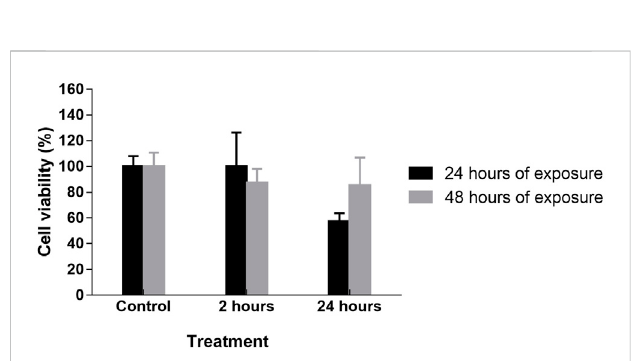
Analysis of Ag@ACF cytotoxicity expressed by cell viability percentage of Vero cells, DMEM treated for 2 and 24 h. Cytotoxicity assessed by MTT assay and cell viability evaluation veri fi ed after 24 and 48 h of exposure in Ag@ACF-treated DMEM